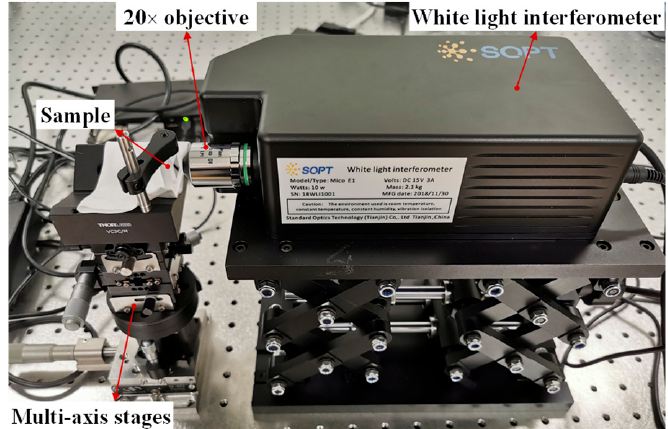
Figure 7. Experimental setup of step height measurements.